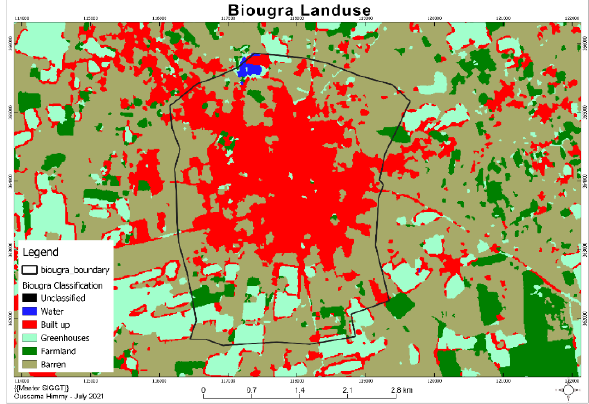
Figure 4 . Biougra city landuse